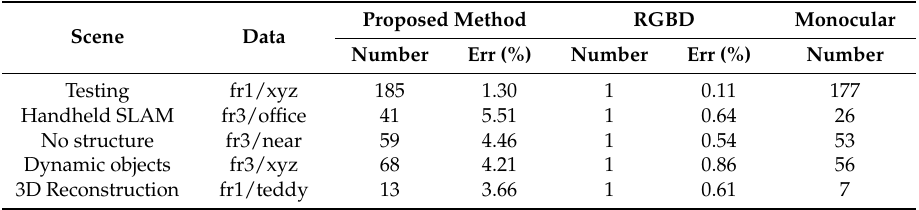
Table 1. Evaluation of the initial efficiency and accuracy.